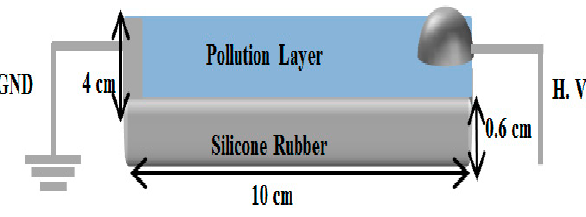
Figure 2. The electrode setup and sample configuration.